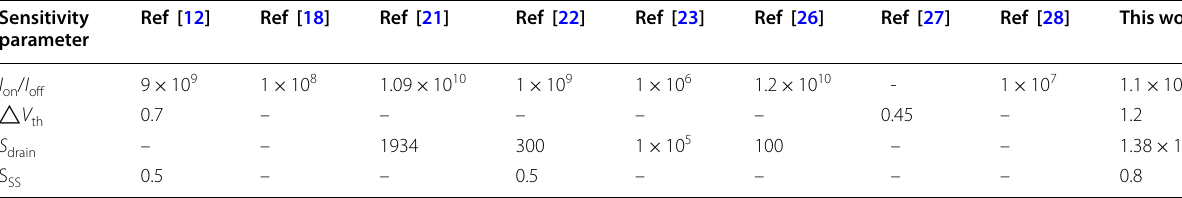
Table 1 Sensitivity comparison of DM-DSTGTFET biosensor with other reported TFET biosensors Sensitivity parameter